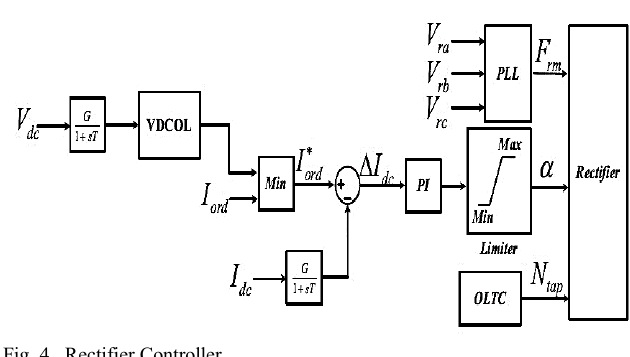
Fig. 4. Rectifier Controller.